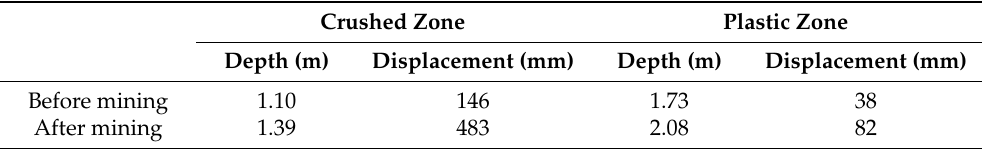
Table 2. The extent and deformation of plastic zone and crushed zone before and after